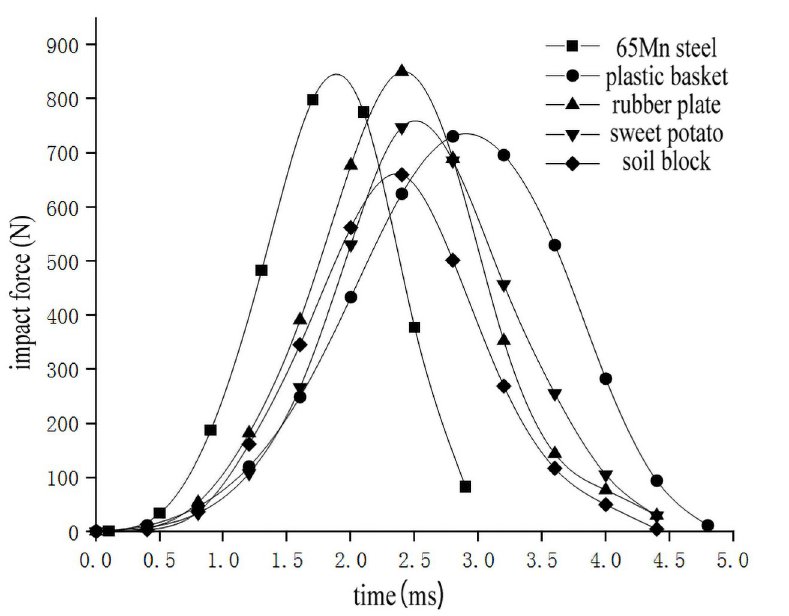
Fig 12. Impact force-time relationship when impacting with different collision